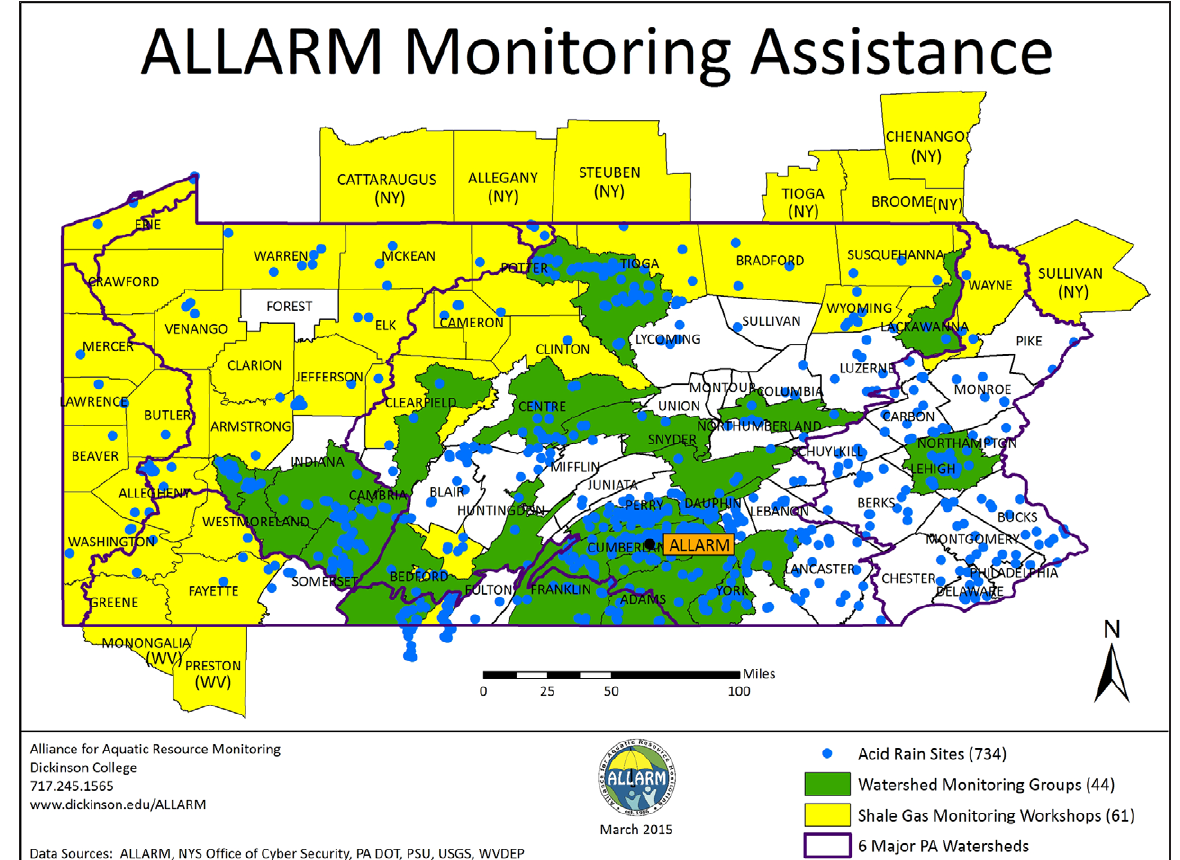
Figure 3: The geographical reach of ALLARM’s three major projects over the course of their history.